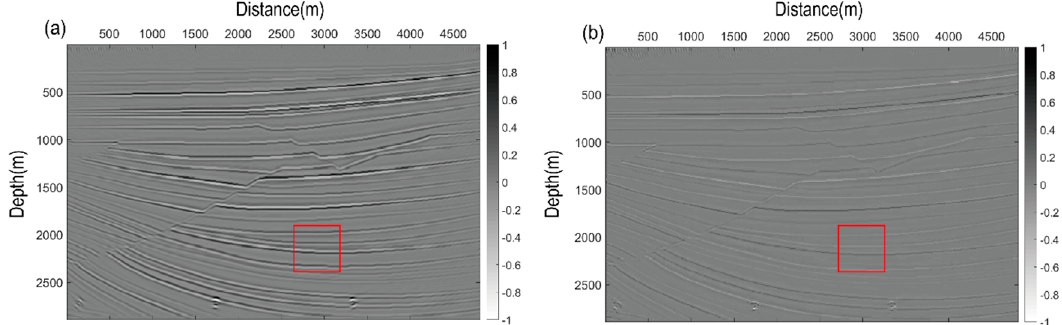
Figure 3. The conventional GBM imaging result ( a ) by using Equation (3), and its corresponding image corrected with the PSF ( b ) by using Equation (5). The image after correction has more balanced amplitudes at both shallower and deeper parts of the model, and the detail comparison of the bandwidth can be shown in wavenumber domain in Figure 4.